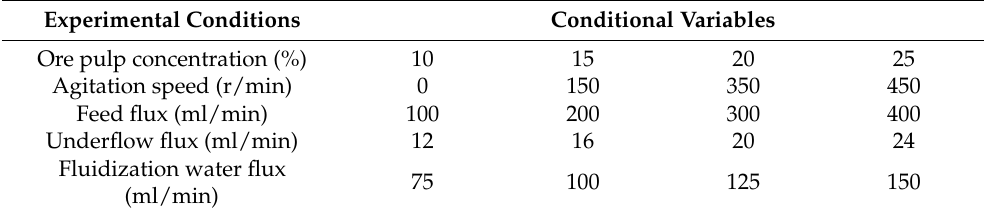
Table 2. Factor-level table of single-factor test.